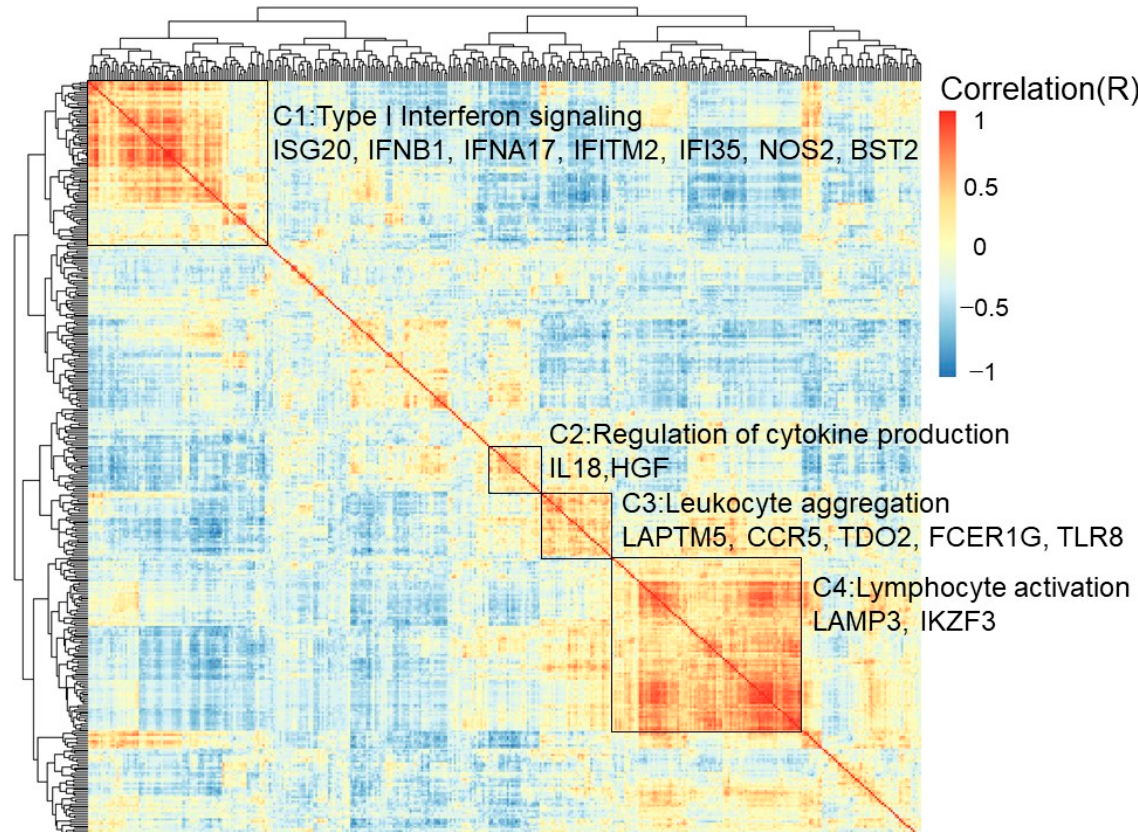
Figure 5. Biological process of FCER1G and its co-expressed immune genes. Clustered heatmap showing the co-expressed immune response genes and related biological processes. FCER1G and its co-expressed immune response genes were grouped into cluster 3, which implied leukocyte aggregation. Type I interferon signaling was enriched with genes in cluster 1, including the prognostic ISG20 , IFNB1 , IFNA17 , IFITM2 , IFI35 , NOS2 , and BST2 eGenes. Cytokine production regulation was enriched with genes in cluster 2, including the prognostic IL18 and HGF eGenes. Leukocyte aggregation genes, including the prognostic LAPTM5 , CCR5 , TDO2 , FCER1G , and TLR8 eGenes, were enriched in cluster 3. Lymphocyte activation genes, including the prognostic LAMP3 and IKZF3 eGenes, were enriched in cluster 4.